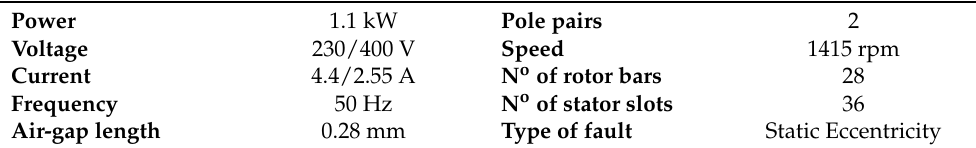
Table 1. Data of the simulated